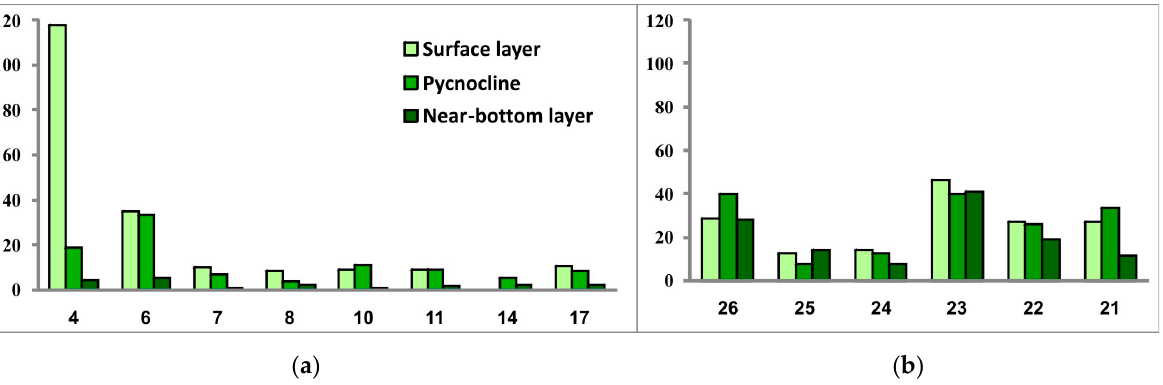
Figure 10. Phytoplankton abundance (thousand cells/L) in the three investigated seawater layers at sampling stations located in the southwestern Kara Sea ( a ) and the southeastern Barents Sea ( b ).